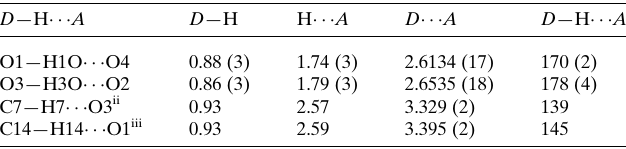
Table 1 Hydrogen-bond geometry (A˚ , (cid:4)